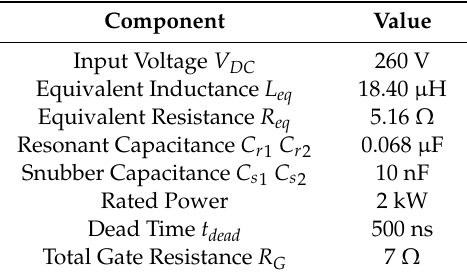
Table 2. Value of circuit components.